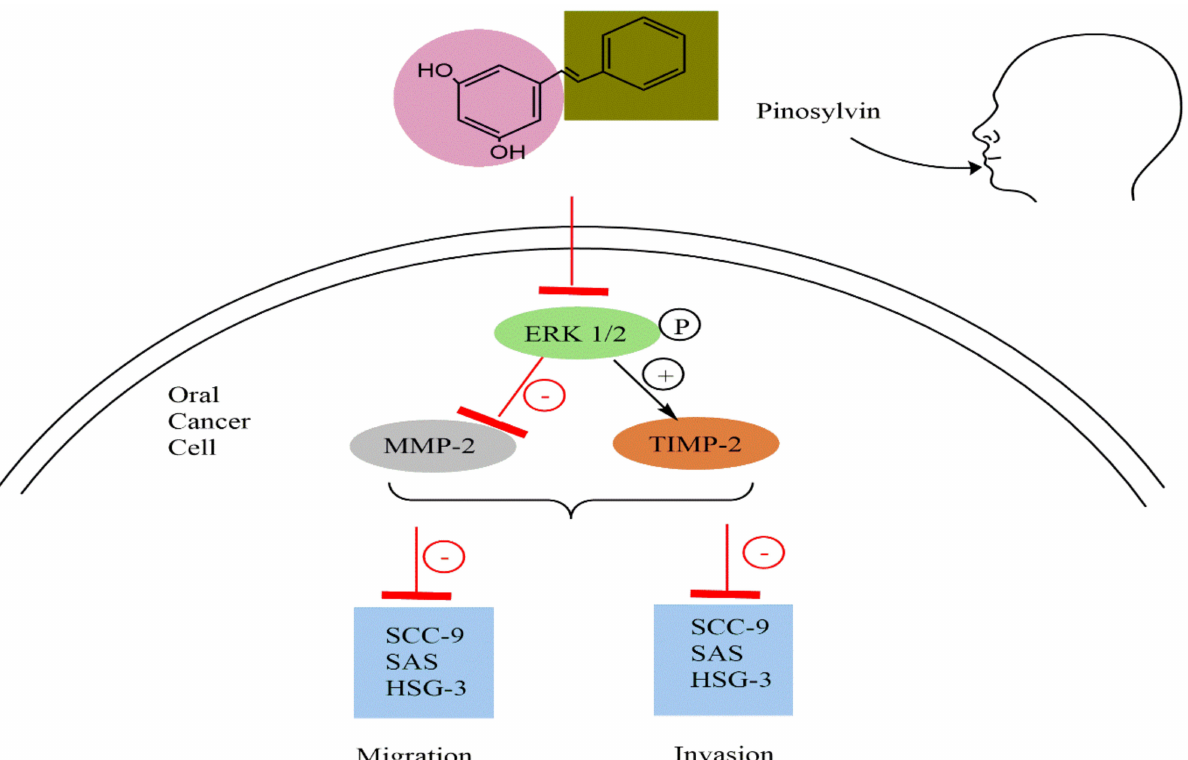
Figure 3. Anticancer activity of pinosylvin against oral cancer cells. Pinosylvin suppressed the invasion and migration of oral cancer cells by inhibiting the phosphorylation of ERK1/2 protein expression in SAS and SCC-9 cells. Abbreviations: MMP-2, matrix metalloproteinase-2; TIMP-2, tissue inhibitor of metalloproteinase-2; ERK, extracellular signal-regulated